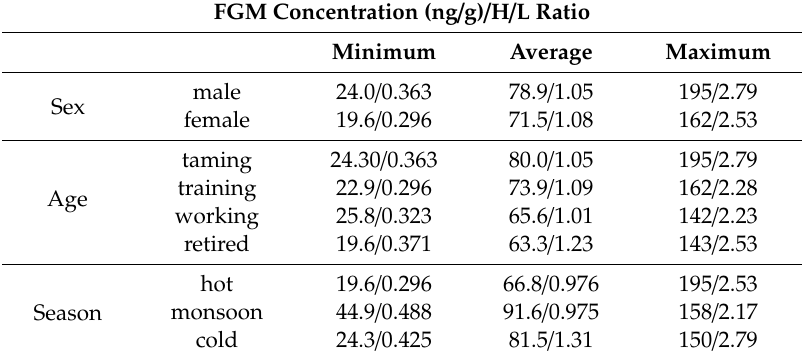
Table 1. Minima, maxima, and average values of FGM concentrations and H / L ratios for di ff erent categories of Asian elephants (sex, age, and